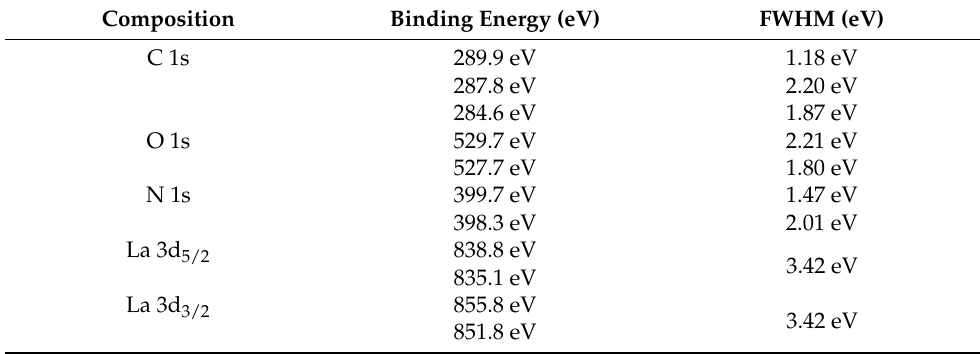
Table 1. Position and full width half